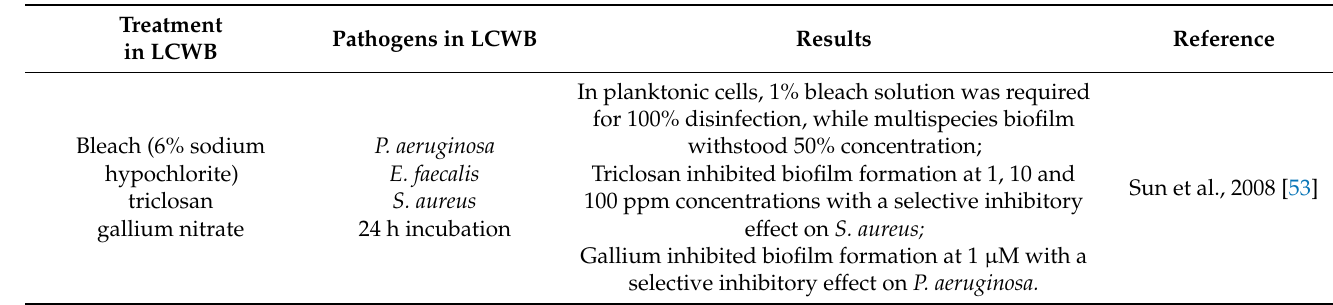
Table 1. Studies conducted using the LCWB